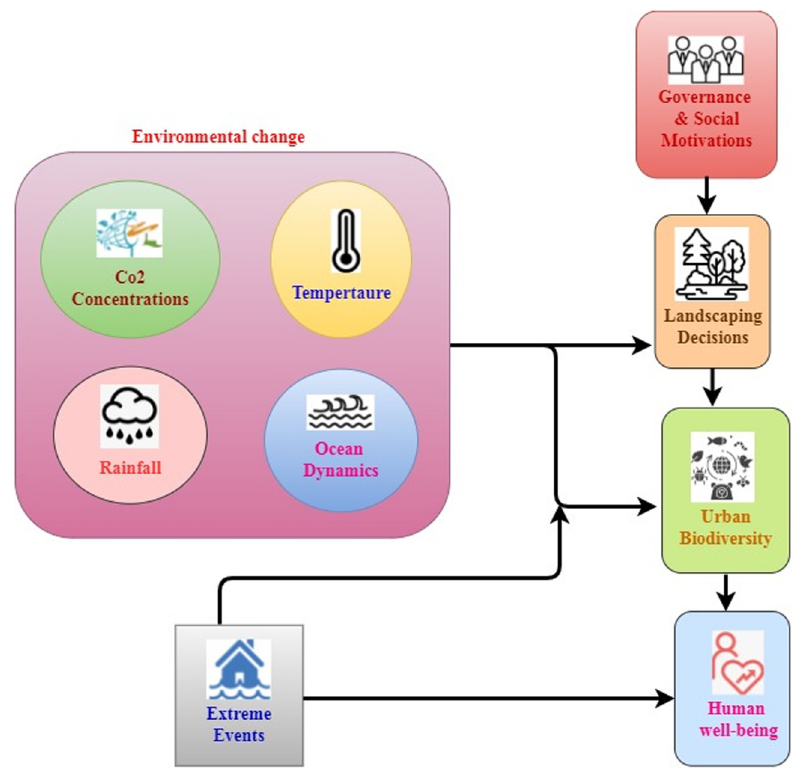
Figure 1: Environmental